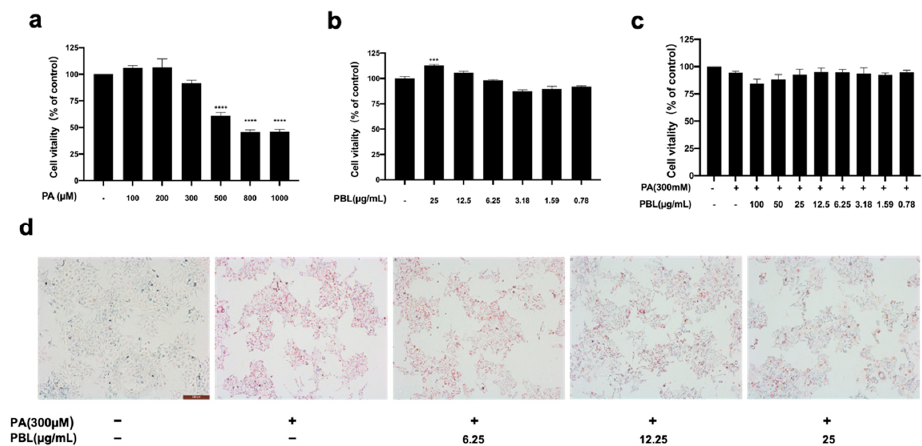
Figure 5. The effect of PBL on the viability of NAFLD-modeled cells. ( a ) Effects of palmitic acid (PA) on cell viability. HepG2 cells were incubated with different concentrations of PA for 48 h. ( b ) The result of PBL (0.78–100 µg/mL) on cell viability after 48 h of exposure. ( c ) Effect of PBL on PA-induced cell viability reduction. HepG2 cells were treated with PBL (0.78–100 µg/mL) and induced by PA (300 µM) for 48 h. ( d ) HepG2 cells evaluated by Oil Red O staining. The data represent as mean ± SEM for n = 3 studies. *** p < 0.001, **** p < 0.0001 compared with the control group.